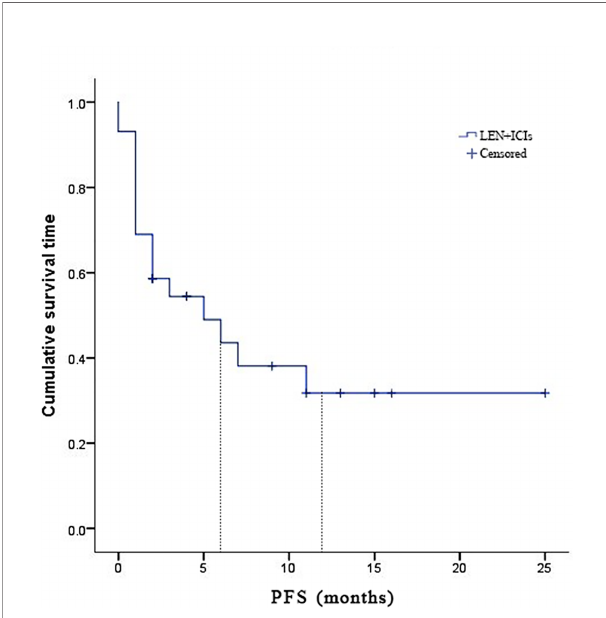
FIGURE 1 | Kaplan-Meier estimates of time to progression for 27 eligible patients with advanced hepatocellular carcinoma who were treated with lenvatinib plus immune checkpoint inhibitors.